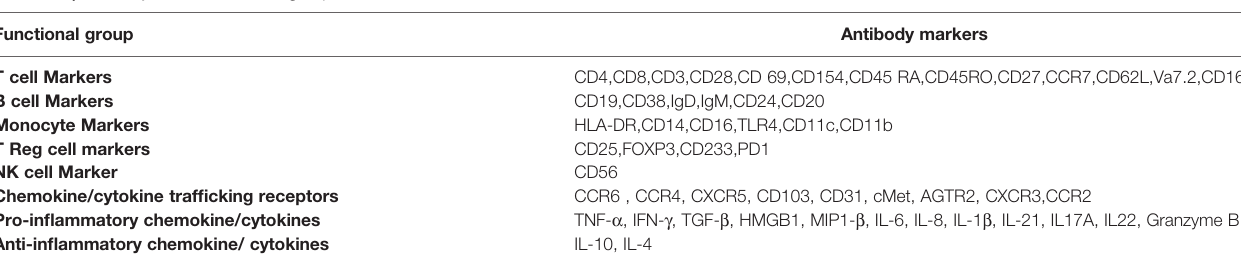
TABLE 2 | Antibody marker functional group. Functional group Antibody